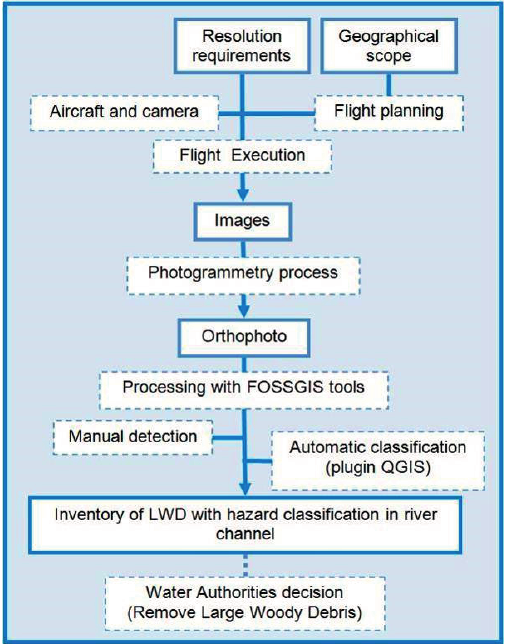
Figure 1. Main flowchart of the proposed methodology. (Dashed line: flux or process; Continuous line: data and newly generated products).